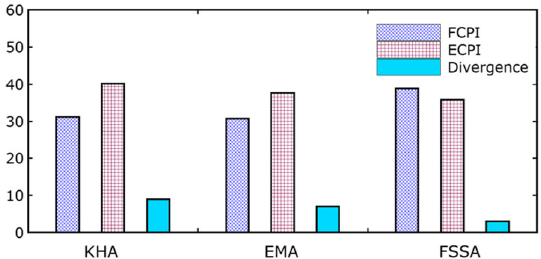
Fig. 5 Performance comparison of the FSSA algorithm with other techniques for EED